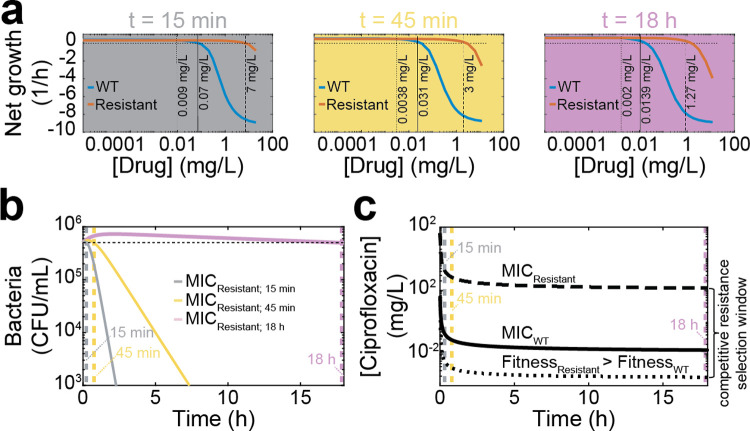
Predicted mutation selection windows for E. coli exposed to ciprofloxacin.a, The drug concentration of ciprofloxacin is shown on the x-axes, and the average bacterial net growth rate in the first 15 min (grey panel), 45 min (yellow panel), and 18 h (purple panel) of exposure is given on the y-axes. The blue line represents the wild-type strain based on the fits shown in Fig 3, and the red line represents a strain with a hypothetical resistance mutation that decreases the binding rate (kf) 100-fold and imparts a 15% fitness cost. The horizontal dotted line indicates no net growth. The vertical dotted line indicates where the resistant strain becomes more fit than the wild-type, the solid vertical line indicates the MIC of the wild-type, and the dashed vertical line indicates the MIC of the resistant strain. b, Modeled time kill curves of the resistant strain for ciprofloxacin concentrations at which there is no growth at 15 min (grey; MIC15 min = 7 mg/L), 45 min (yellow; MIC45 min = 3 mg/L) and 18 h (purple; MIC18 h = 1.27 mg/L). The horizontal dotted line indicates the initial population size; the vertical dotted lines represent the time points at which the initial and final population size is the same. c, The mutation selection window depends on the time at which bacterial growth is observed. The x-axis shows the observed time at which replication rates were determined, the y-axis shows ciprofloxacin concentrations. The dotted curve shows the ciprofloxacin concentration at which the resistant becomes fitter than the WT (FitnessResistant > FitnessWT), the solid line the MIC of the WT (MICWT), and the dashed line the MIC of the resistant strain (MICResistant). The area between the dotted and dashed line indicates the competitive resistance selection window.